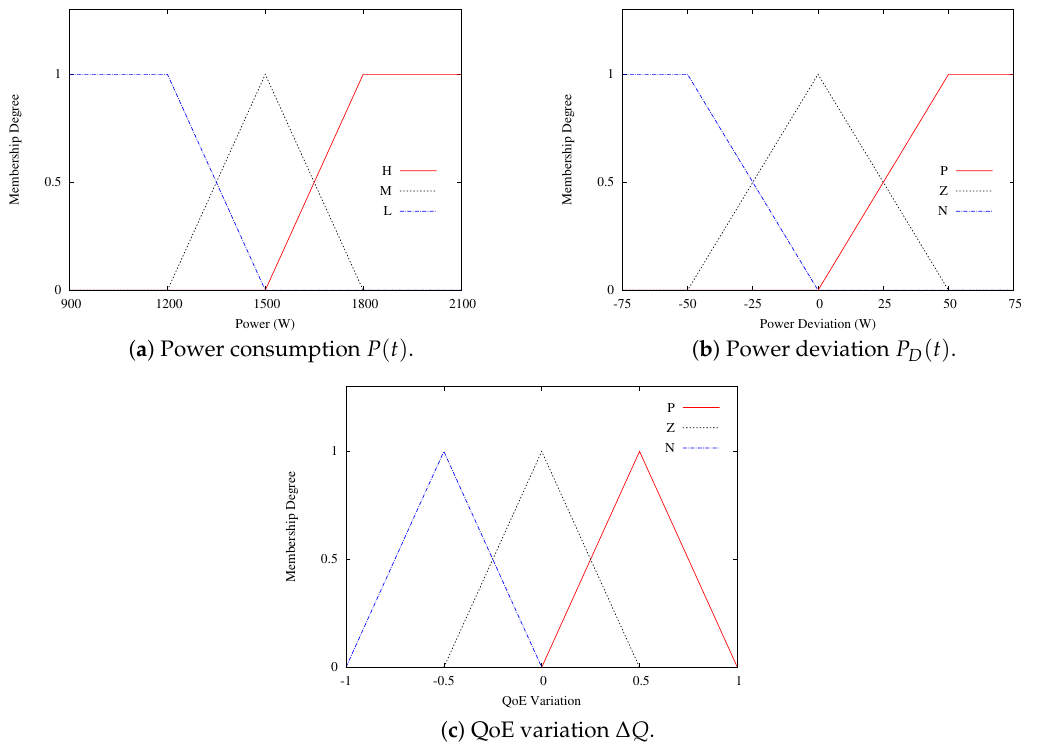
Figure 4. Membership functions of the proposed fuzzy logic